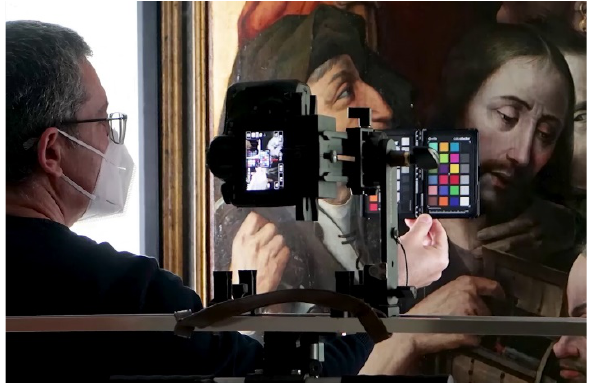
Figure 2 . ColorChecker card used as a reference blank for achieving an optimal colour accuracy.